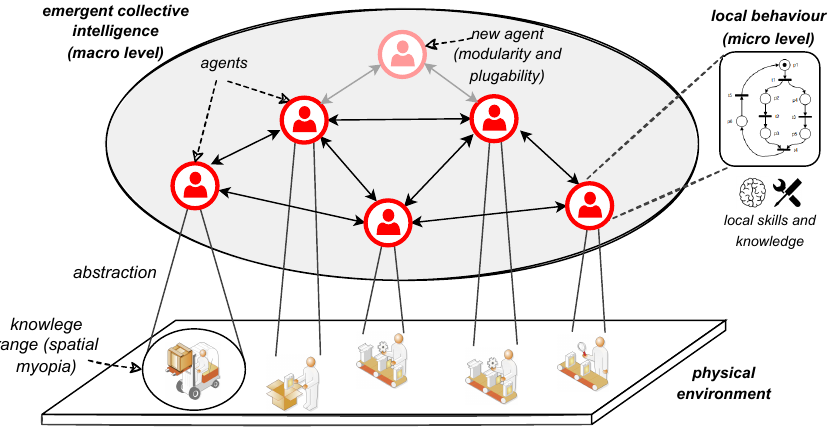
Figure 1. Features of collective intelligence in an agent-based CPS.